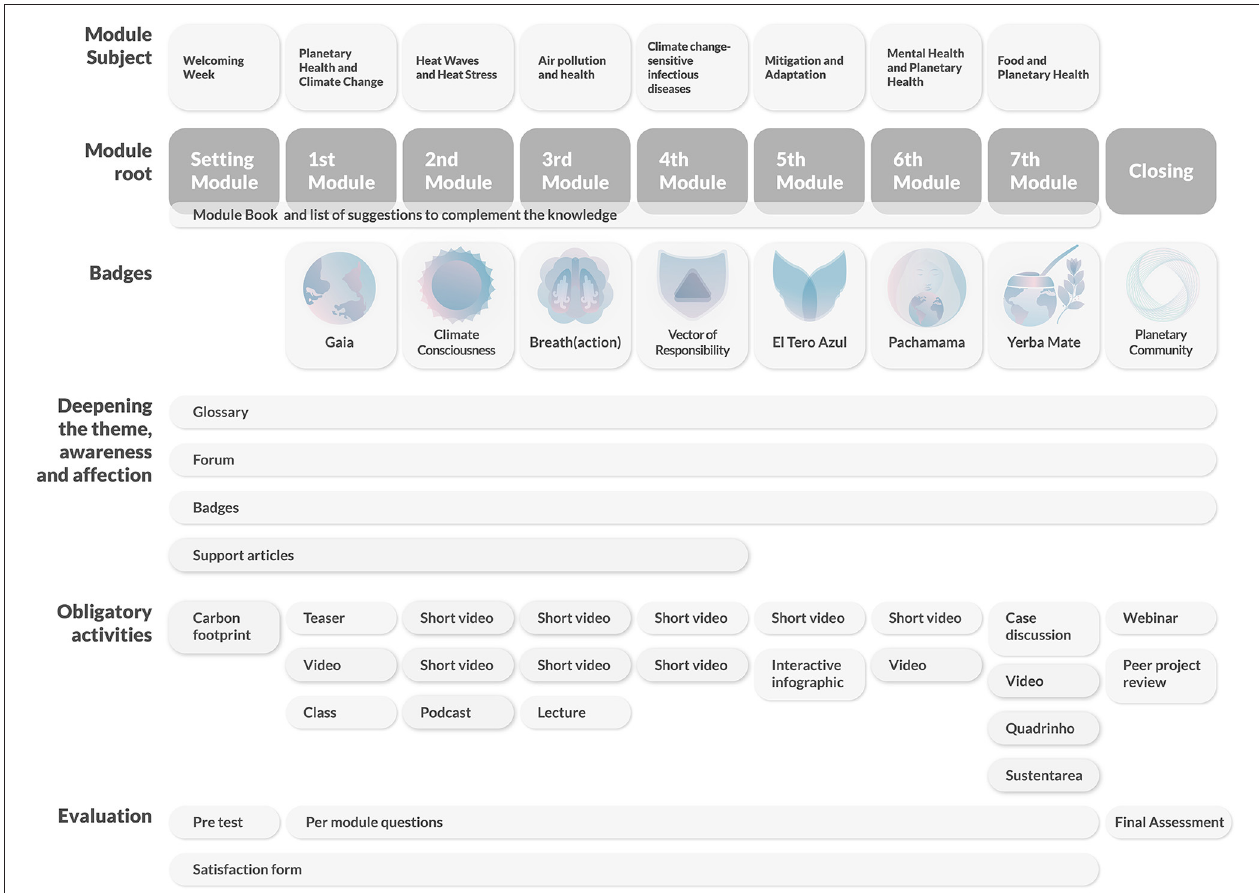
FIGURE 3 | Content structure, root, and its deepening axis. Illustration credit: Iasmine Paim Nique da Silva and Lorenzo Costa